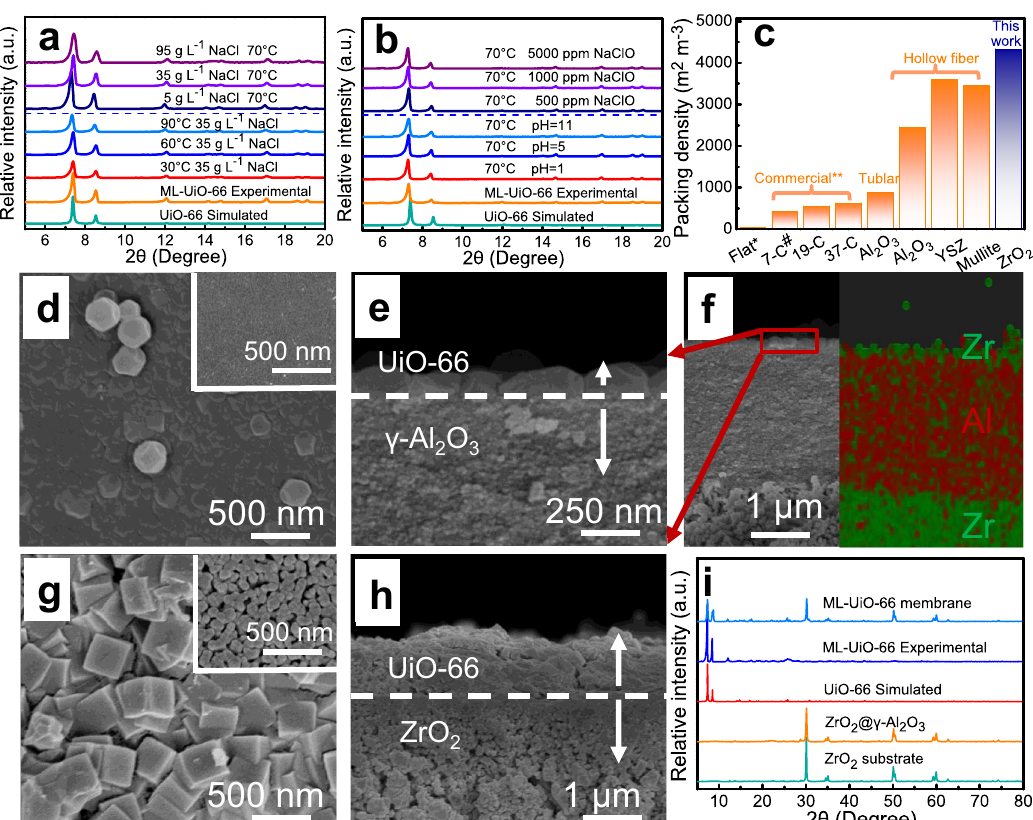
Fig. 2 Stability and structure characterization. a X-ray diffraction (XRD) patterns of ML-UiO-66 before and after 10-day long-term immersion into saline solutions at different temperatures (30, 60, and 90 °C) and different salt concentrations (5, 35, and 95 g L − 1 ). b XRD patterns of ML-UiO-66 after 10-day immersion into aqueous salt solutions with different pH values (1, 5, and11) and different NaClO concentrations (500, 1000, and 5000 ppm). c Comparison of packing density between ZrO 2 substrate in this work and other ceramic substrates 60 – 62 (*Shandong Industrial Ceramic Research & Design Institute Co., Ltd., China, **Great Wall Xinyuan Membrane Technology Co., Ltd., China, # C refers to the number of channels for commercial tubular multi-channel alumina ceramic membranes). d Surface fi eld emission scanning electronic microscopy (FE-SEM), ( e ) high-magni fi cation cross-sectional image and ( f ) cross-sectional energy dispersive spectroscopy (EDS) image (zirconium element: green signal; aluminum element: red signal) of ultrathin ML-UiO-66 membrane after in situ direct growth on lower-roughness ZrO 2 @ γ -Al 2 O 3 substrate with much fi ner pores (the inset of ( d )). g Surface FE-SEM and ( h ) cross-sectional images of thick ML-UiO-66 membrane with large inter-crystalline defects after in situ direct growth on macro-porous ZrO 2 substrate (the inset of ( g )). i XRD patterns of ultrathin ML-UiO-66 membrane (on ZrO 2 @ γ -Al 2 O 3 substrate), ML-UiO-66 powder, UiO-66 (calculated), ZrO 2 @ γ -Al 2 O 3 substrate, and ZrO 2